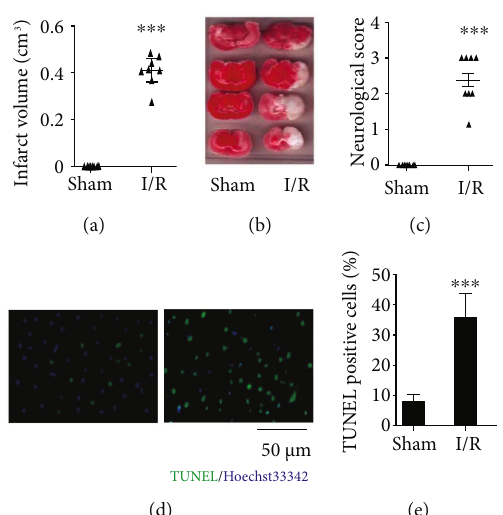
Figure 1: Neuronal histological changes induced in CI/R injury rat. (a) Infarction size. (b) Representative images of TTC staining. (c) Neurological function analysis. (d) Representative images of TUNEL/Hoechst double staining. (e) TUNEL-positive cell numbers. The data expressed as mean ± SD ( n = 8 ). ∗∗∗ P < 0 : 001 vs. sham.